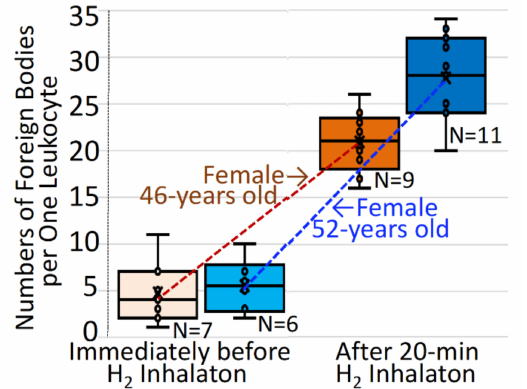
Figure 6. Increases in numbers of intracellular foreign bodies in leukocytes after hydrogen gas inhalation. The subjects inhaled 3% hydrogen gas for 20 min, as in Figure 5, and were evaluated for numbers of foreign endogenous bodies with no count of vacuoles or cysts, per single leukocyte. The intracellular foreign bodies per one leucocyte were quantitatively analyzed for specified number ( n ) of microscopic still-image specimens, each of which contained mostly one, in part two, leucocytes being coexistent among abundant erythrocytes, before/after hydrogen inhalation in two subjects of 46-year-old and 52-year-old females. The individual values for the intracellular foreign bodies per single cell are indicated by open circles, and expressed by a quartile method-based box–whisker